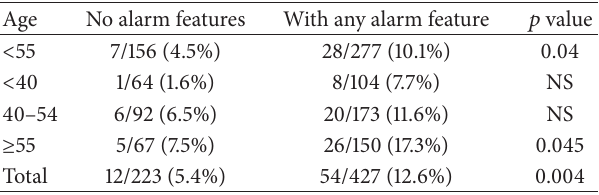
Table 3: Significant endoscopic findings in patients with and without alarm features stratified by age; Grady Memorial Hospital, Atlanta, Georgia, June 1, 2011–July 1, 2015.